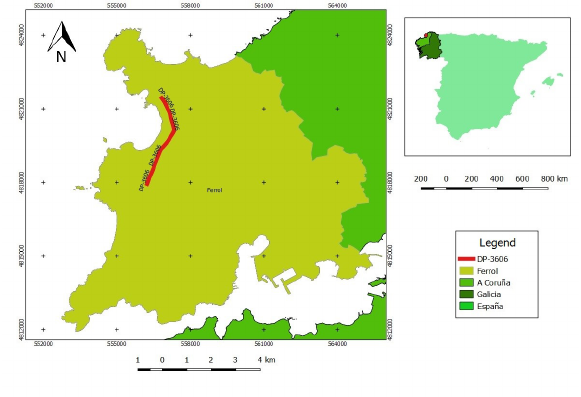
Figure 1. Location of DP-36006 road.